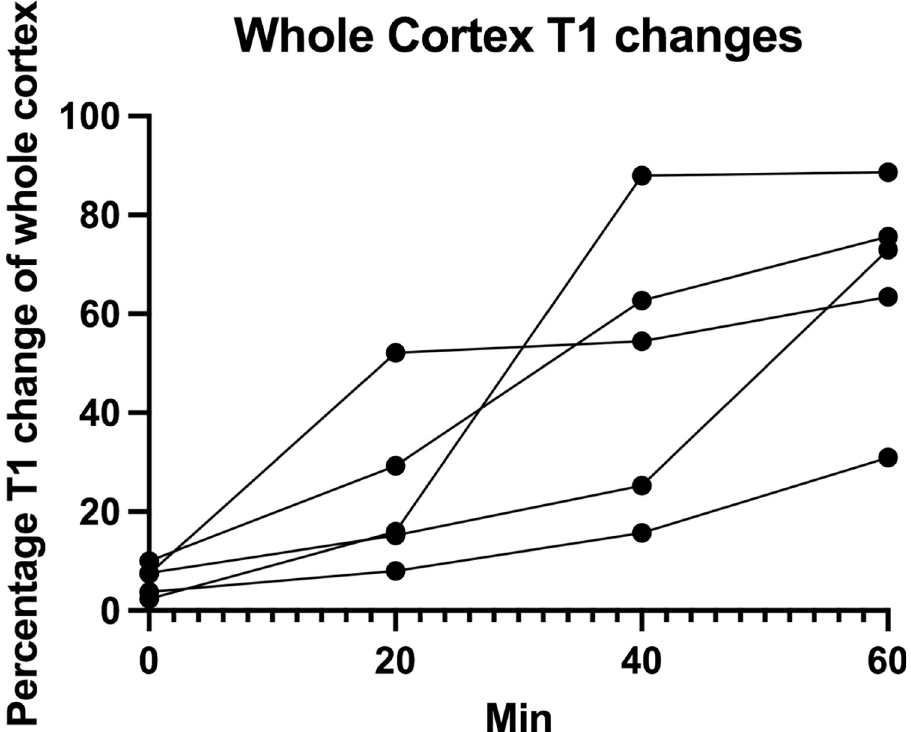
Fig 4. Whole cortex changes. Fraction of whole cortex T1 changes as a function of time from baseline scan to 60 mins. scan for all 5 experimental animals. The curves are ended at 60 mins. as some of the experiments were ended at this time point. At 60 minutes a mean of 66% of the cortex was affected by intrarenal backflow.